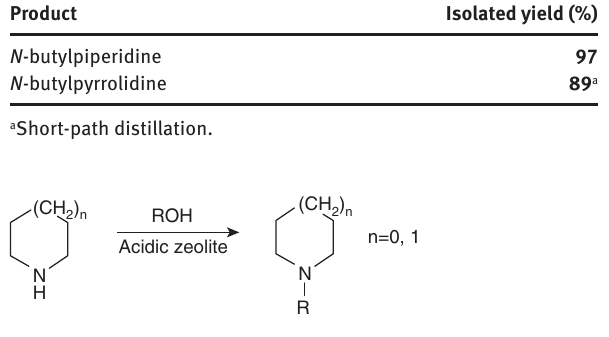
Product Isolated yield (%)